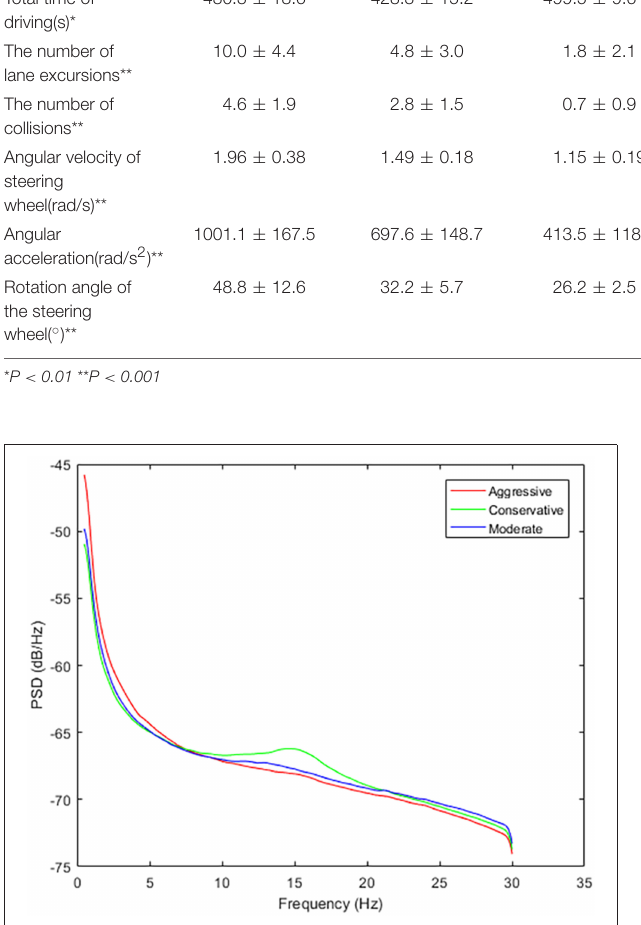
FIGURE 5 | Power spectrum of different driving styles. An obvious bump can be observed in the Conservative group around